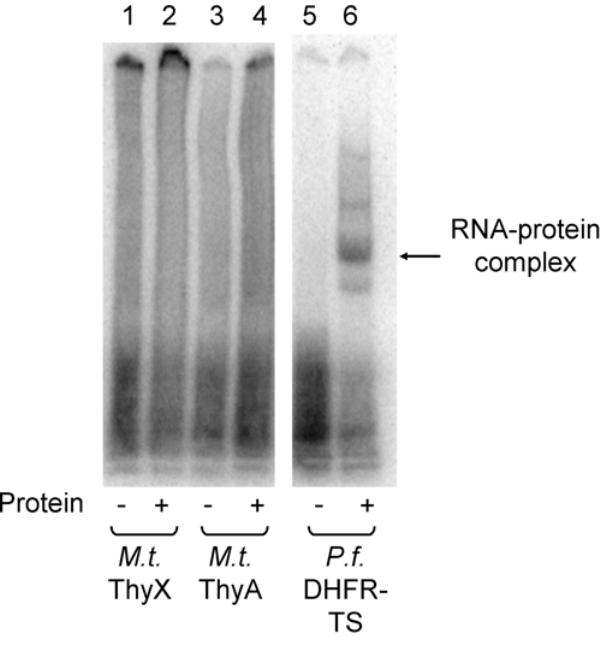
Figure 3. RNA binding by M.tuberculosis ThyA and ThyX. M. tuberculosis thymidylate synthases do not bind to their cognate mRNA. 0.35 nM of 32 P labeled M. tuberculosis ThyX mRNA (lanes 1 and 2), M. tuberculosis ThyA mRNA (lanes 3 and 4), or P. falciparum DHFR-TS mRNA (lanes 5 and 6) was incubated in the presence or absence (lanes 1, 3, and 5) of purified M. tuberculosis ThyX (3.5 m M, lane 2), M. tuberculosis ThyA (3.5 m M, lane 4), or P. falciparum DHFR-TS (500 nM, lane 6). Unbound RNA was digested with 3 units of RNase T1 prior to electrophoresis [22].